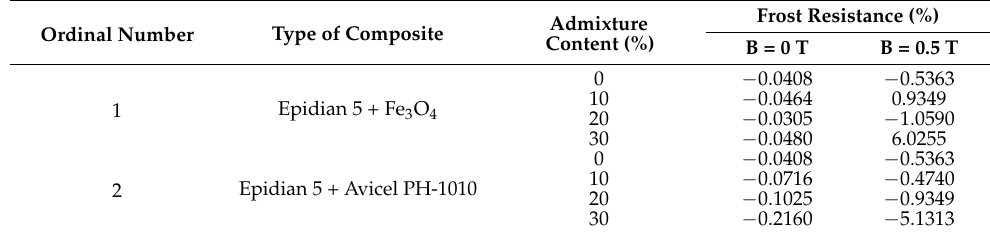
Table 17. Frost resistance of composites.